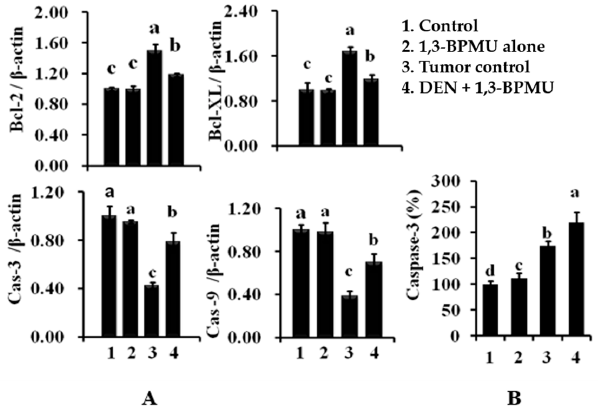
Figure 3. Impact of 1,3-BPMU on apoptotic and anti-apoptotic gene expression in control and experimental animals. ( A ) Bcl-2, Bcl-XL, caspase-3 and caspase 9 mRNA expression in experimental rats; ( B ) Quantification of caspse-3 protein expression in experimental rats. Different letters, a, b, c, d, within a treatment between concentrations of 1,3-BPMU indicate significant differences ( p < 0.05).